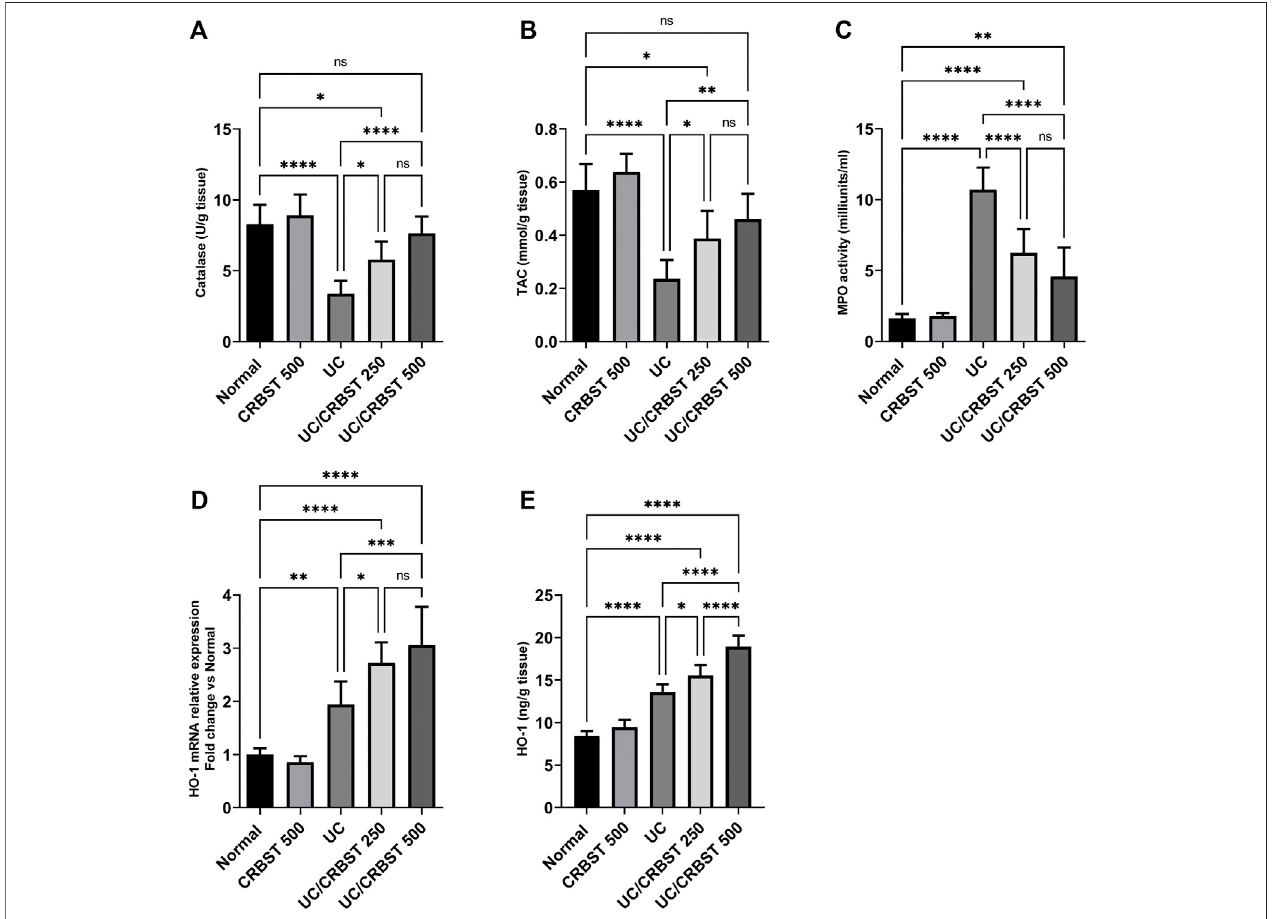
FIGURE 3 | Effect of CRBST 250 and 500 mg/kg on catalase (A) ; TAC (B) ; MPO activity (C) ; HO-1 mRNA (D) ; and HO-1 (E) in rats with AA-induced UC. Results are shown as the mean ± SD (n = 6). * p < 0.05, ** p < 0.01, *** p < 0.001, **** p < 0.0001. Normal, normal control rats administered the vehicle; CRBST 500, normal rats administered carbocisteine (500 mg/kg); UC, AA-induced UC rats administered the vehicle; UC/CRBST 250, AA-induced UC rats treated with carbocisteine (250 mg/kg); UC/CRBST 500, AA-induced UC rats treated with carbocisteine (500 mg/kg).